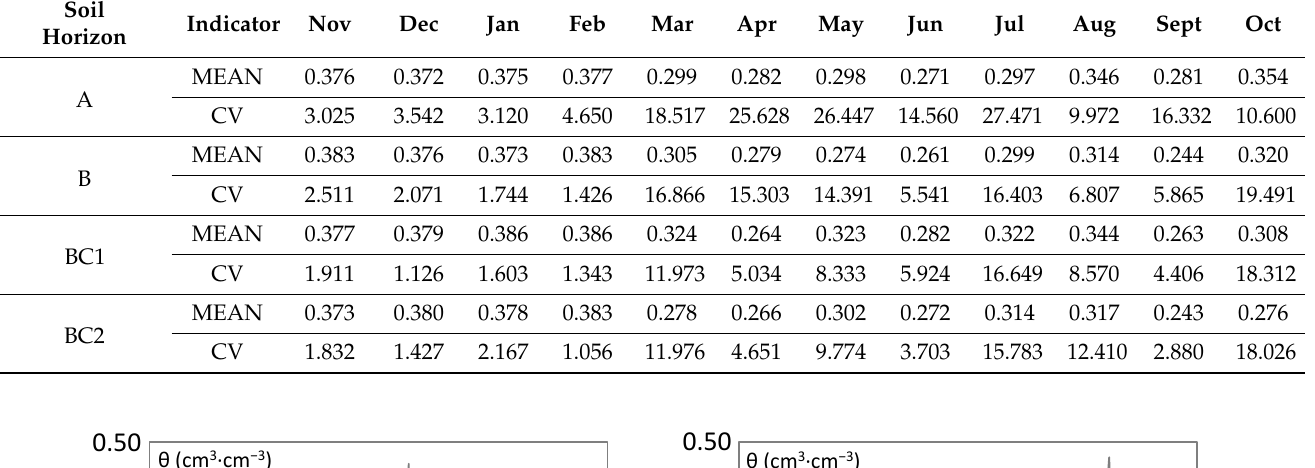
Table 7. Monthly means of the soil water content (cm 3 · cm − 3 ) and coefficients of variance (CV) in HY 2015.